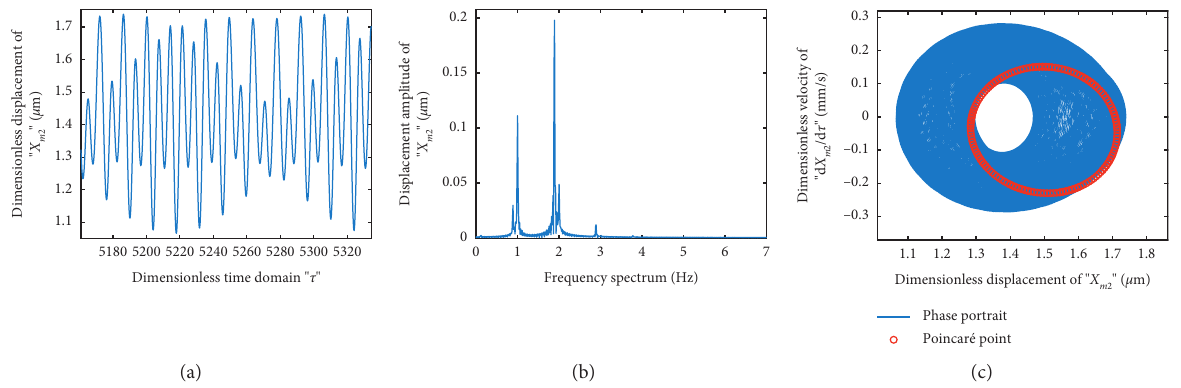
Figure 15: The dynamic response of system X